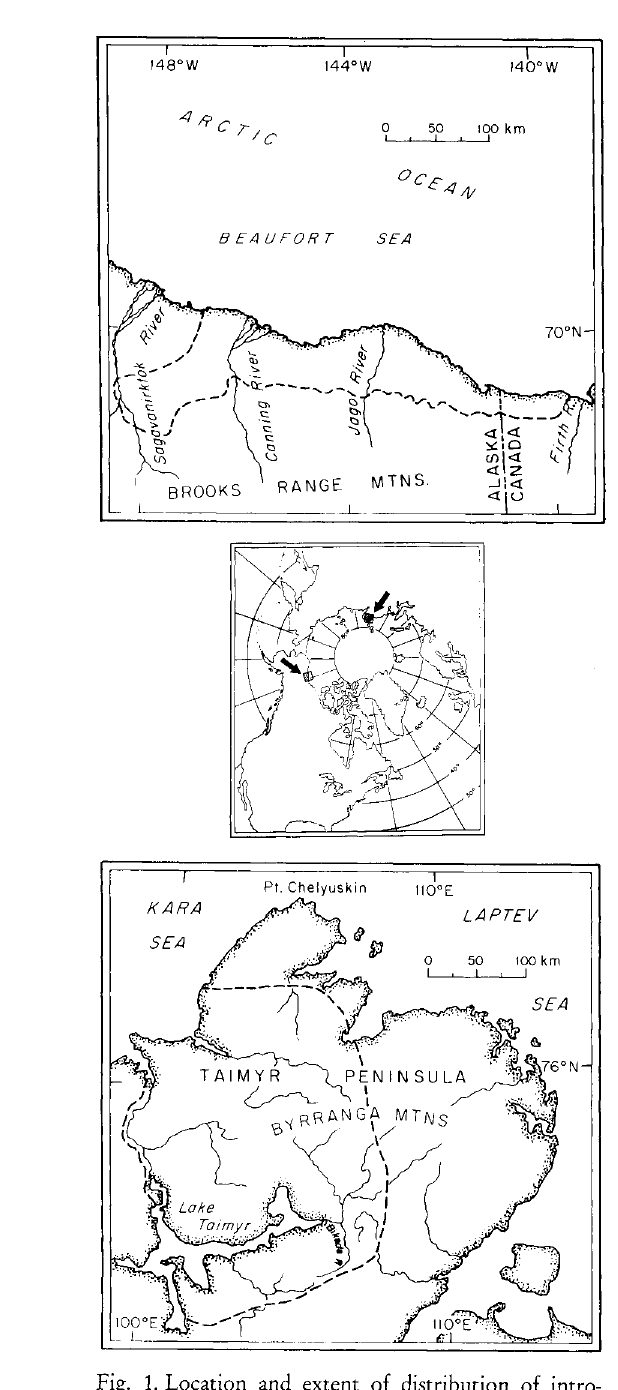
Fig. 1. Location and extent of distribution of intro duced muskox populations in northeastern Alaska and the Taimyr